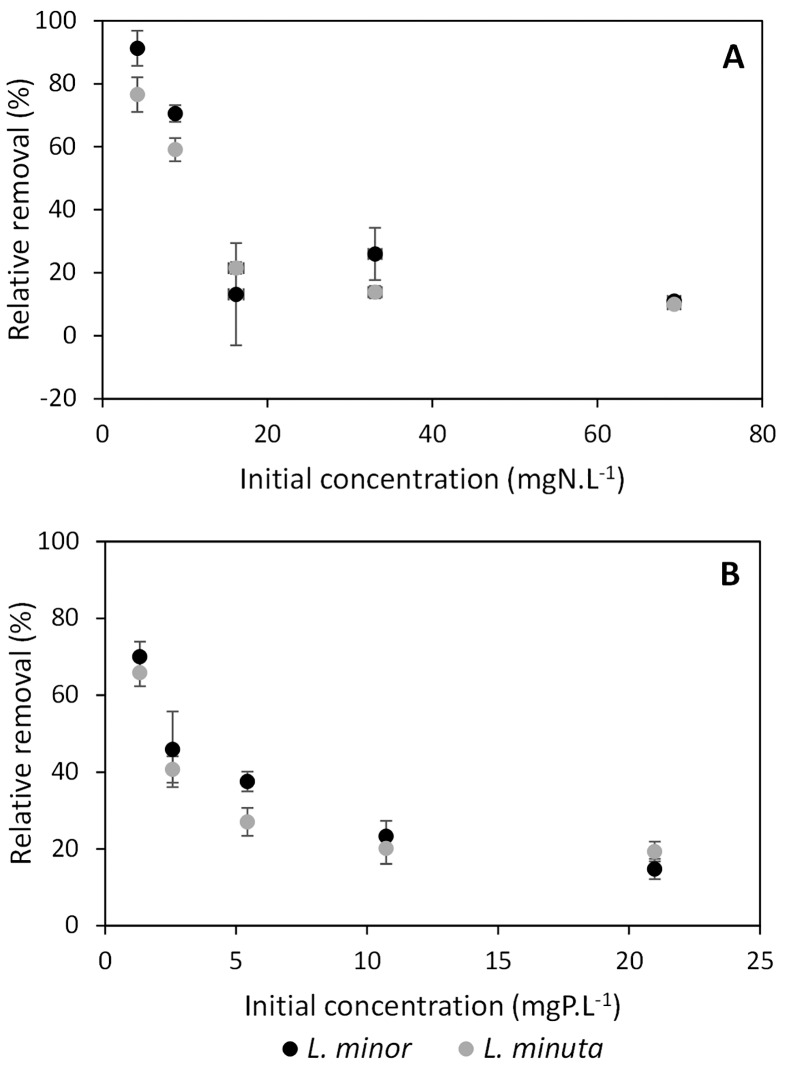
Relative removal of nutrients by L. minor (black circles) and L. minuta (grey circles).A: nitrogen removal. B: phosphorus removal. At low nutrient concentrations relatively high nutrient removal efficiencies are observed.